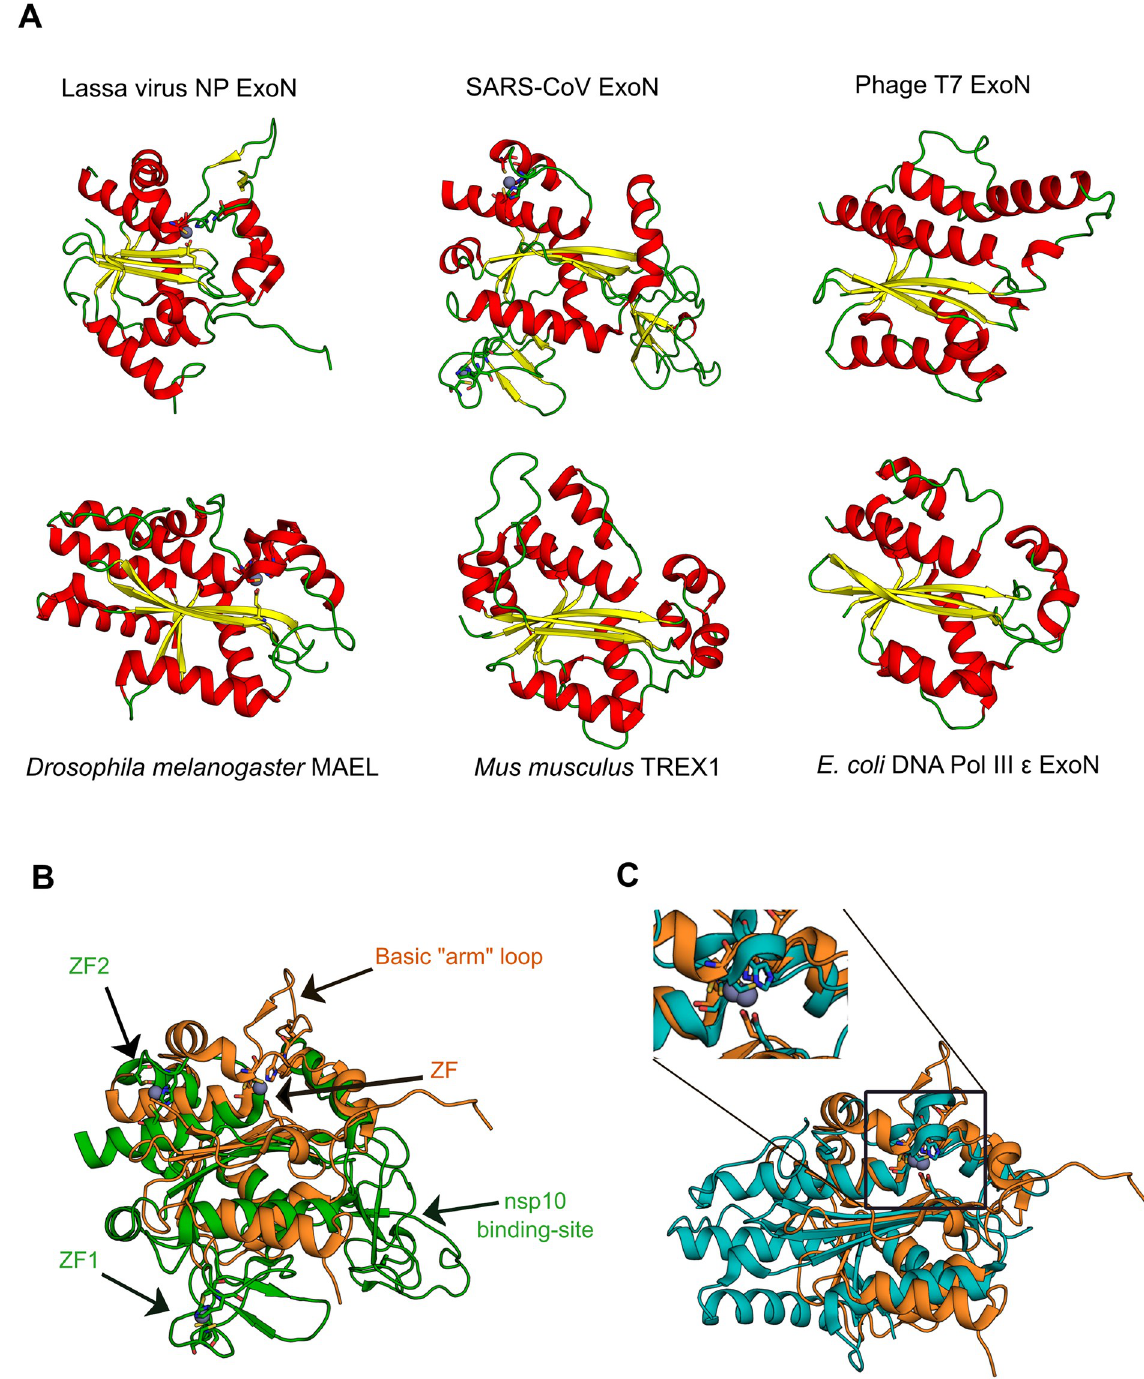
Fig 4. Structural comparisons of DnaQ-like exonucleases. (A) Structural conservation among the DnaQ-like nucleases. ɑ -helices colored in red; β -sheets in yellow; and connecting elements in green. (B) Structural superposition between Lassa virus NP exonuclease (PDB ID: 3Q7V), orange; and SARS-CoV ExoN domain (PDB ID: 5C8U), green. (C) Structural superposition between Lassa virus NP exonuclease (PDB ID: 3Q7V), orange; and Drosophila melanogaster Maelstrom (PDB ID: 4YBG), blue. Herein, the presence of the ZF (ECHC) in both proteins is